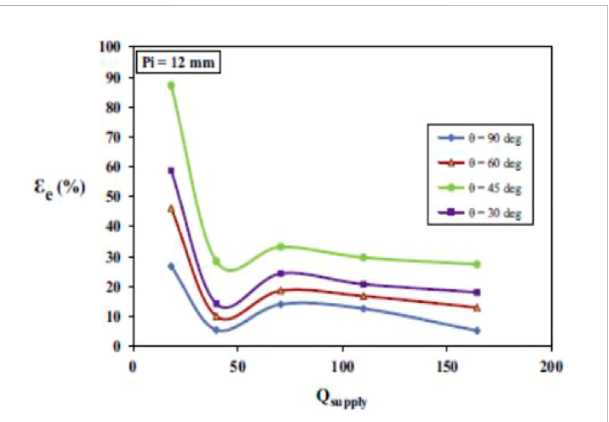
FIGURE 14 Embossed fi n effectiveness as a function of heat supplied for different values of impression angles at Pi (Fin Pitch) = 12 mm (Singh and Patil,